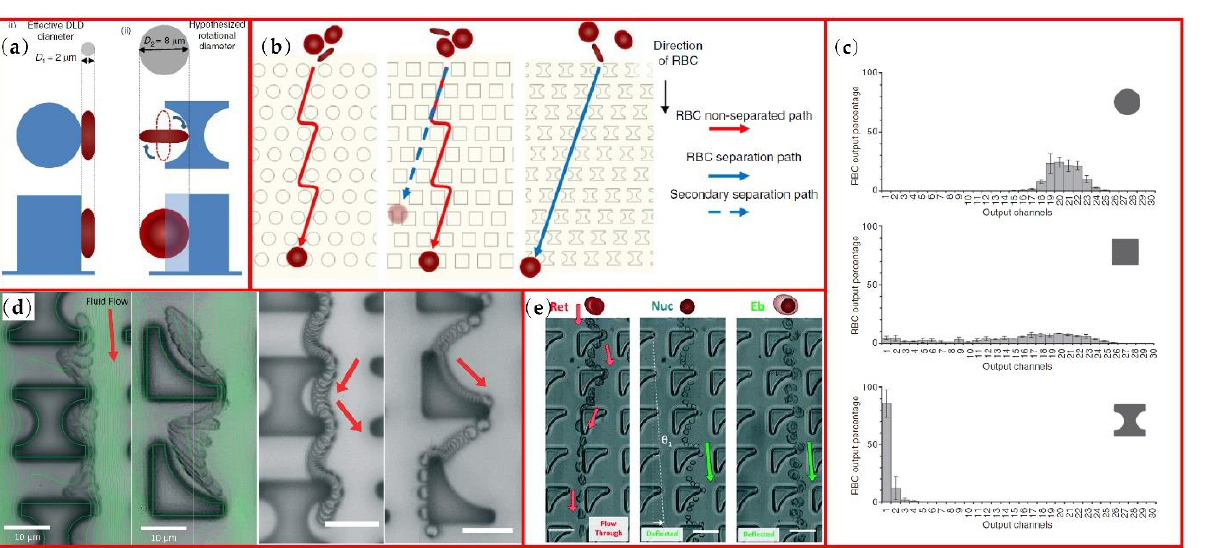
Table 2. Recent advances in passive manipulation of non-spherical particles in microchannels. Particle Non- spherical Straight particles (except H- shaped) Cylindrical particle